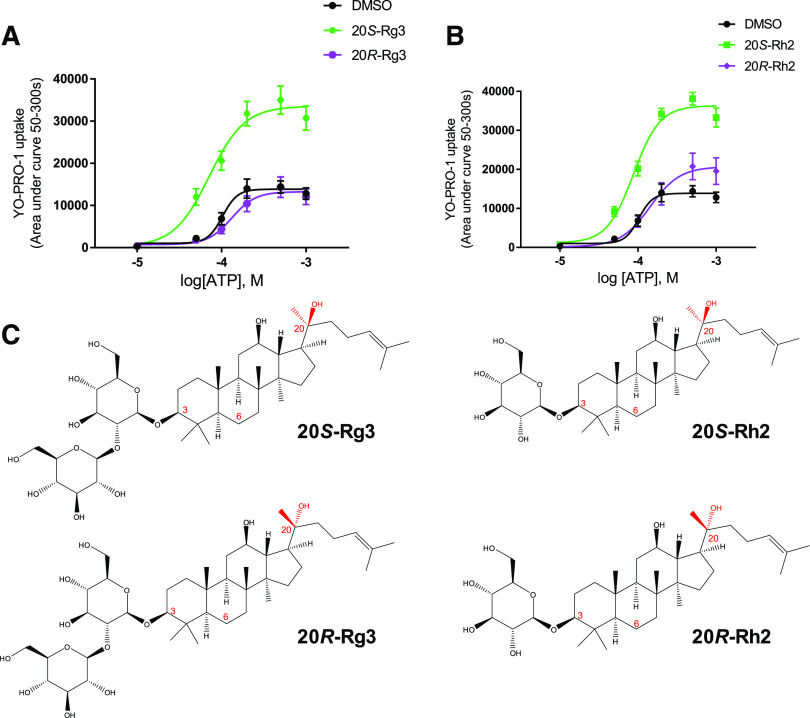
Diastereoisomers of ginsenosides have different activity at hP2X7. (A) Dose-response curves to ATP in the presence of vehicle (DMSO), 20(S)-ginsenoside-Rg3, or 20(R)-ginsenoside-Rg3 (10 µM). (B) Dose-response curves to ATP in the presence of vehicle (DMSO), ginsenoside-20(S)-Rh2, or ginsenoside-20(R)-Rh2 (10 µM). Data are collated from three independent experiments and are means ± S.D. The same DMSO data are shown in both plots. (C) Chemical structures of ginsenoside-Rg3 and ginsenoside-Rh2 are shown with the stereo-centers highlighted in red.